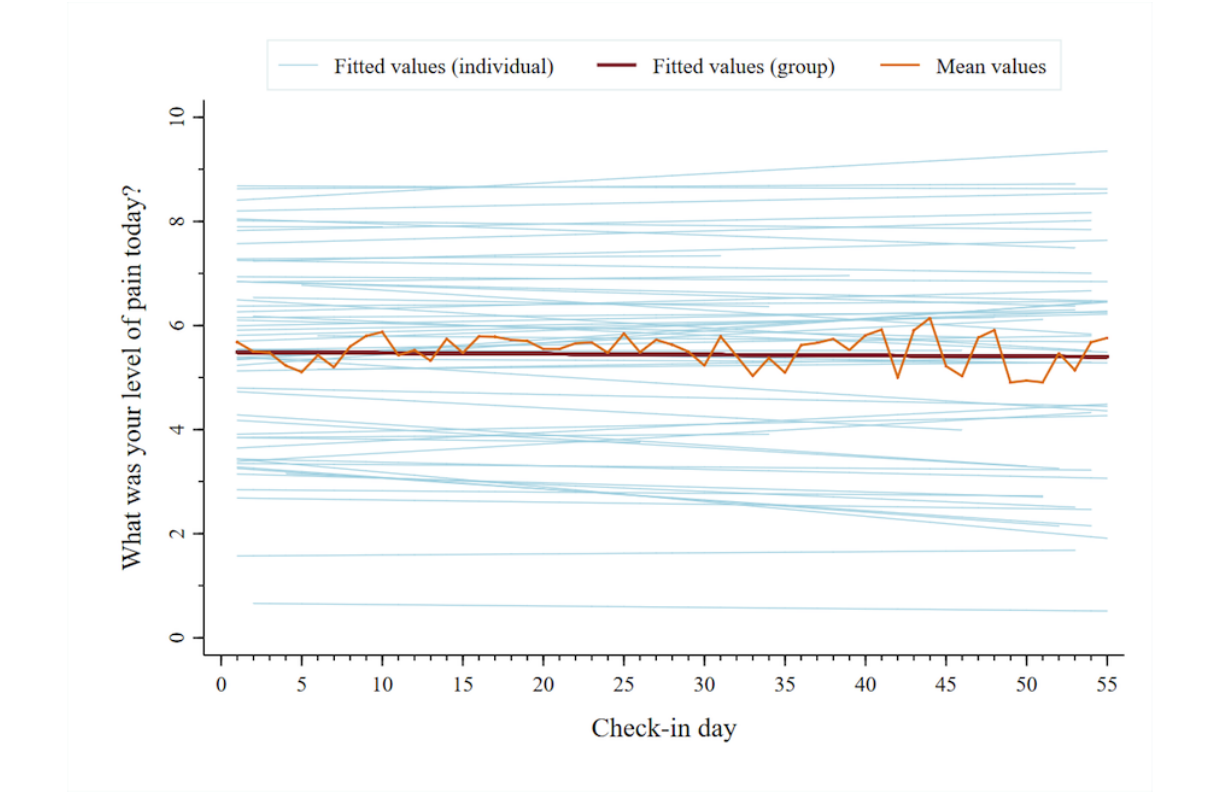
Figure 5. Self-reported pain intensity across 55 days using the iCanCope daily Check-in.